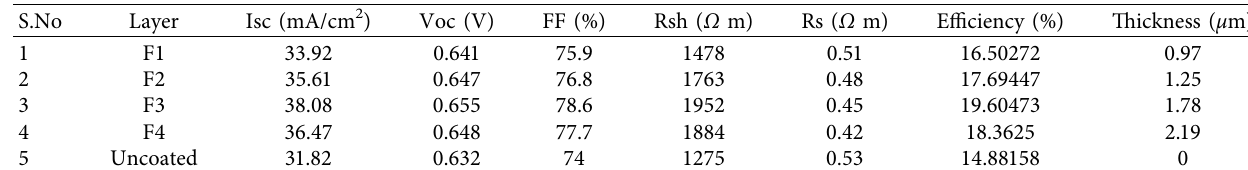
Table 3: I-V assessment under a neodymium light source.